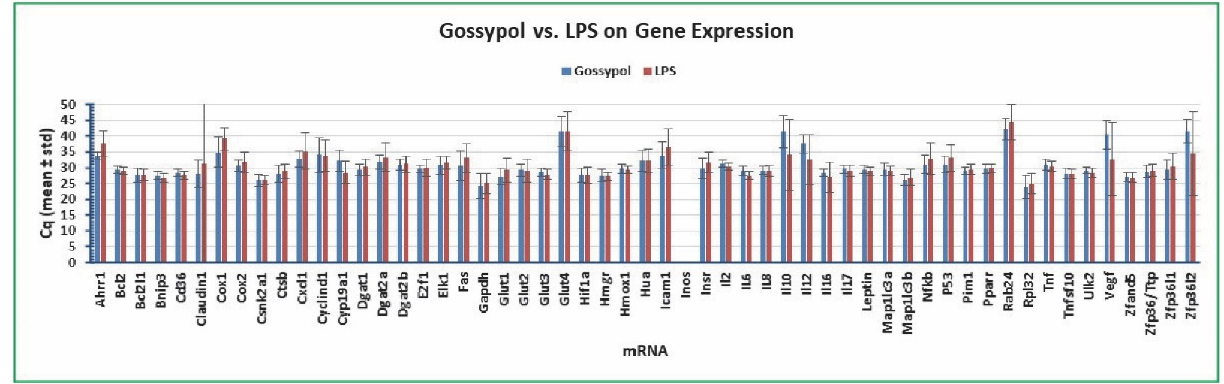
Figure 4. Variation of gene expression between gossypol and LPS treatment. The cancer cells were treated with multiple concentrations of gossypol (0, 0.1, 0.5, 1, 5, 10, 50, and 100 µg/mL) and LPS (0, 5, 10, 20, 50, 100, 500, and 1000 ng/mL) for 8 h. Total mRNAs were extracted from the cells, converted into cDNAs, and the relative abundance was analyzed by SYBR Green qPCR. The Cq values represented the mean and standard deviation of 24 independent samples.